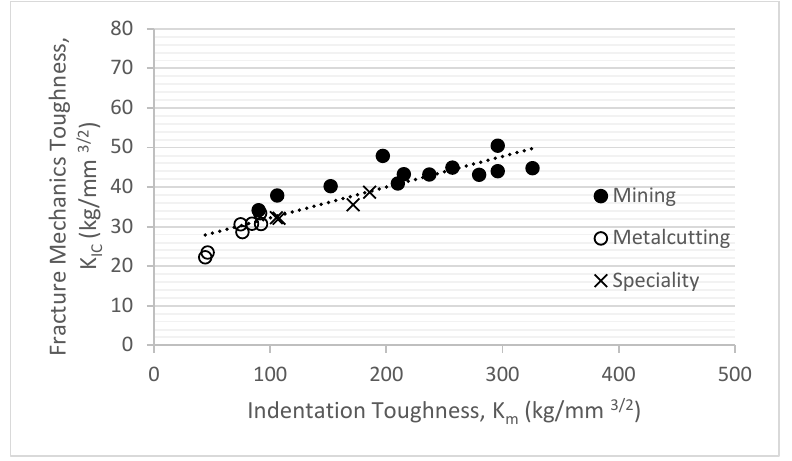
Figure 1. Indentation toughness ( K m ) versus fracture mechanics toughness ( K IC ) for Kennametal grades.